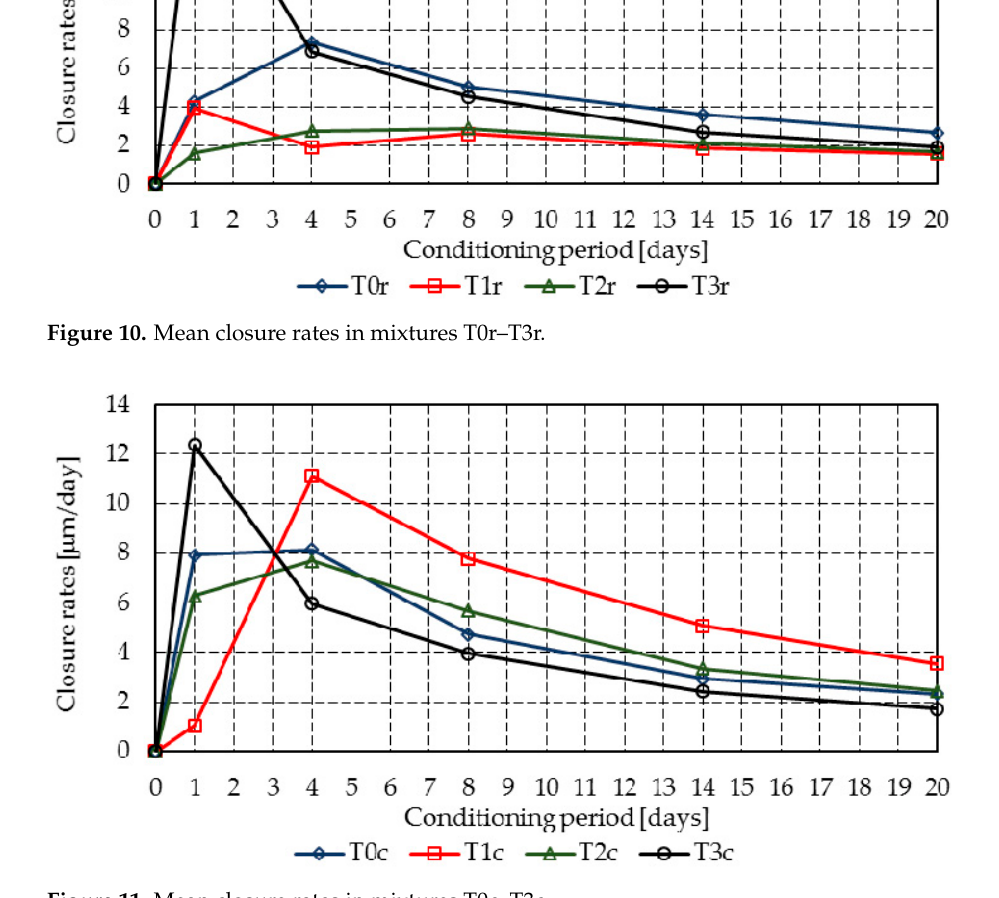
Figure 11. Mean closure rates in mixtures T0c–T3c.